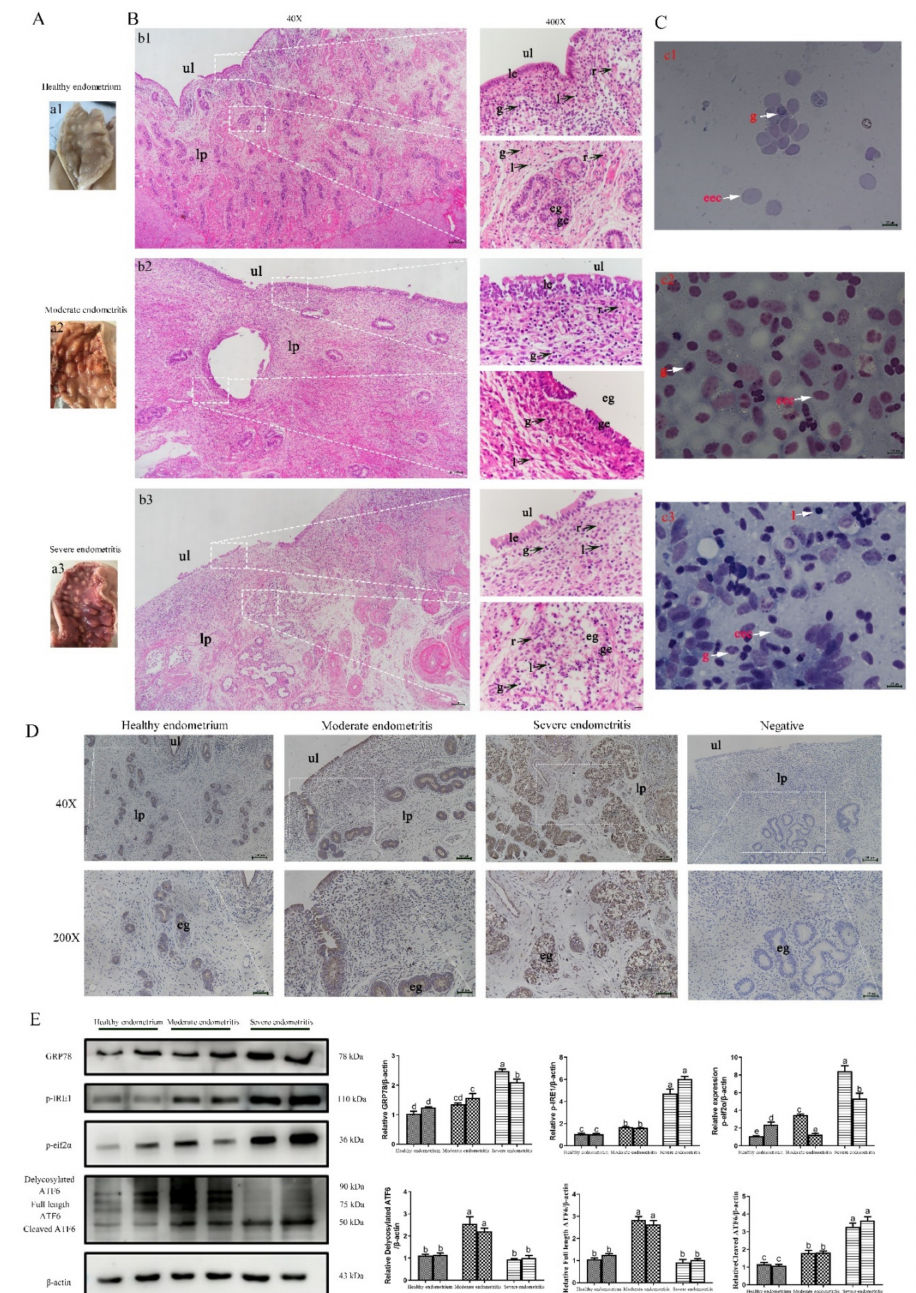
Figure 6. Effect of ERS in dairy bovine endometritis. ( A ) Postpartum bovine uterus was collected for visual inspection. ( B ) Hematoxylin and eosin staining was used to analyze the degree of in- flammation in bovine endometrium. ( C ) Diff staining of uterine cavity mucus was used to assess the degree of inflammation of the uterine tissue. Micrographs of the bovine endometrium show healthy endometrium ( a1 , b1 , c1 ), moderate endometritis ( a2 , b2 , c2 ) and severe endometritis ( a3 , b3 , c3 ). Scale bars = 200 µ m. ( D ) Immunohistochemistry showing the expression of the ERS marker protein GRP78 in bovine uteri with different levels of endometritis. ( E ) The expression of ERS-related pro- teins (GRP78, p-IRE1, p-eif2 α , and ATF6) was measured by Western blotting in bovine uteri with different levels of endometritis. ul = uterine lumen; eg = endometrial gland; le = luminal epithelium; ge = glandular epithelium; lp = lamina propria; g = granulocytes; l = lymphocytes; r = red blood cells; eec = endometrial epithelium cells. The data are means ± SEM of three independent experiments. Bars with different letters indicate significant differences ( p <